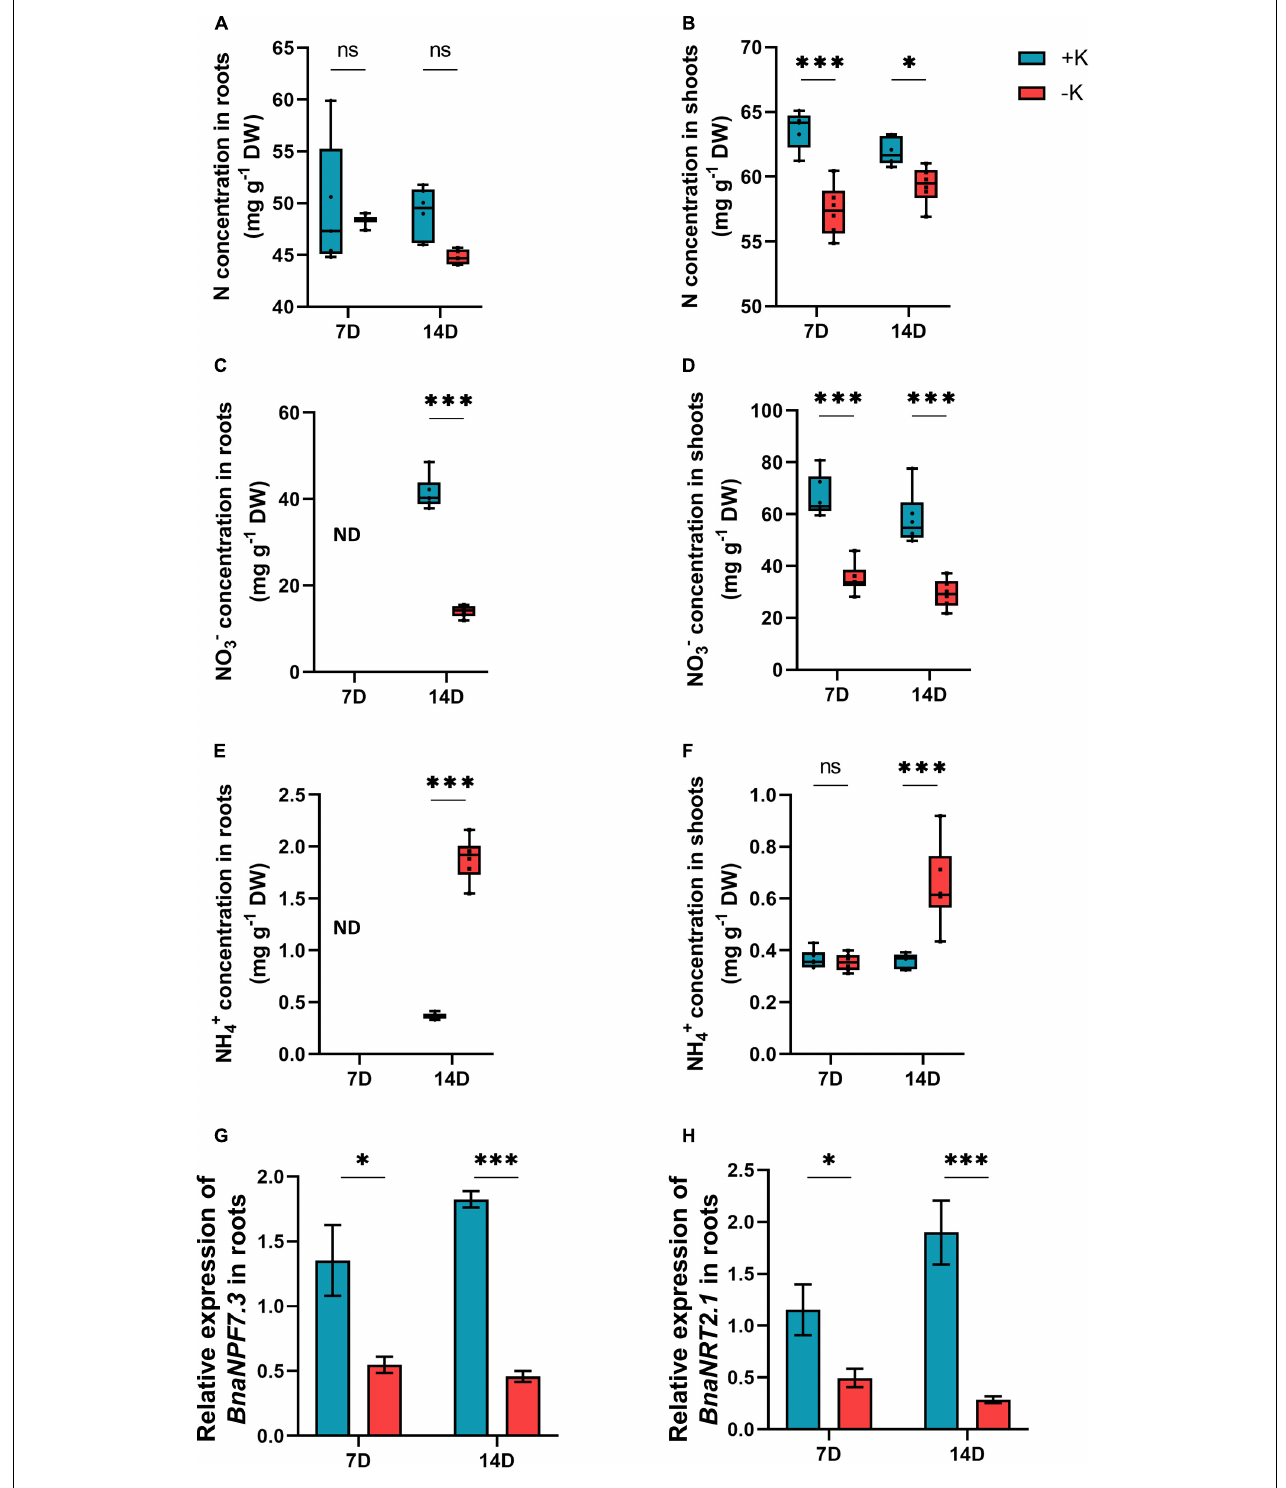
FIGURE 4 | Influence of K deficiency on N concentration and the expression of nitrate transporter in rapeseed. (A) N concentration in roots; (B) N concentration in shoots; (C) NO 3 − concentration in roots; (D) NO 3 − concentration in shoots; (E) NH 4 + concentration in roots; (F) NH 4 + concentration in shoots; (G) relative expression of BnaNPF7.3 in roots and (H) relative expression of BnaNRT2.1 in roots. Plants were grown in a hydroponic culture under either –K (0 mM) or + K (2 mM). The roots and shoots were harvested after 7 or 14 days of K deprivation. Bars indicate mean ± standard error of the mean (SEM) ( n = 6). Asterisks denote the significant level of the difference according to t -test ( ∗ p < 0.05, ∗∗ p < 0.01, and ∗∗∗ p < 0.001, n = 6). Ns denotes non-significant differences.